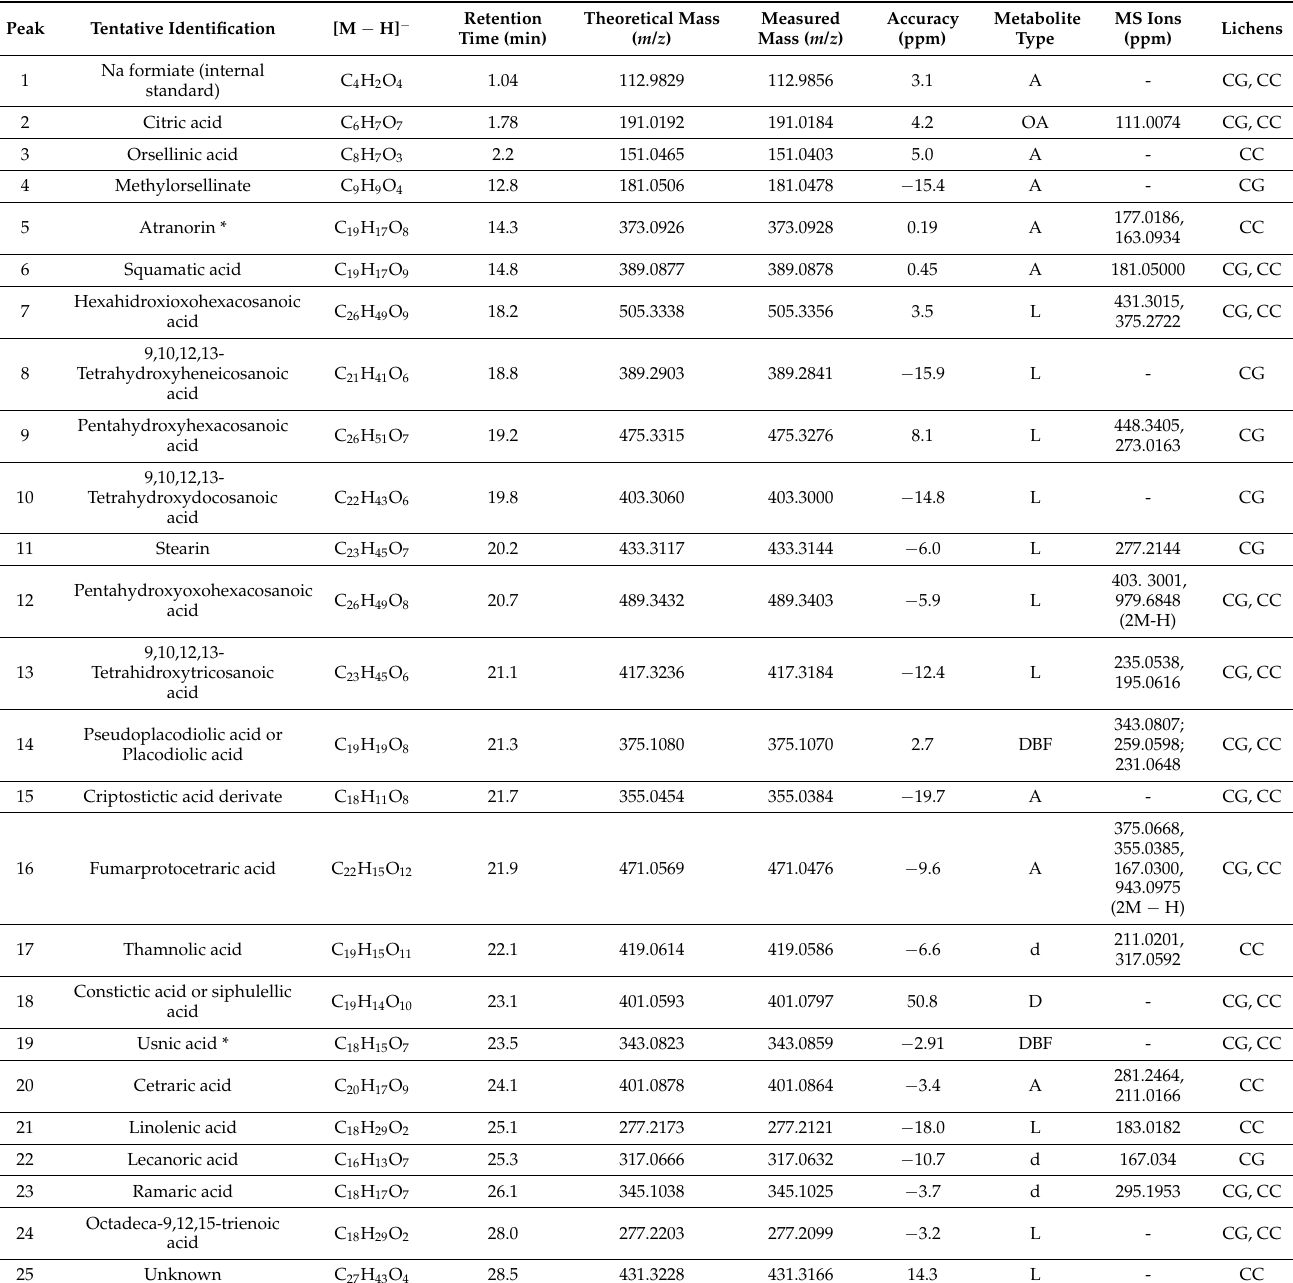
Table 1. Identification of metabolites in C. gracilis and C. chlorophaea by